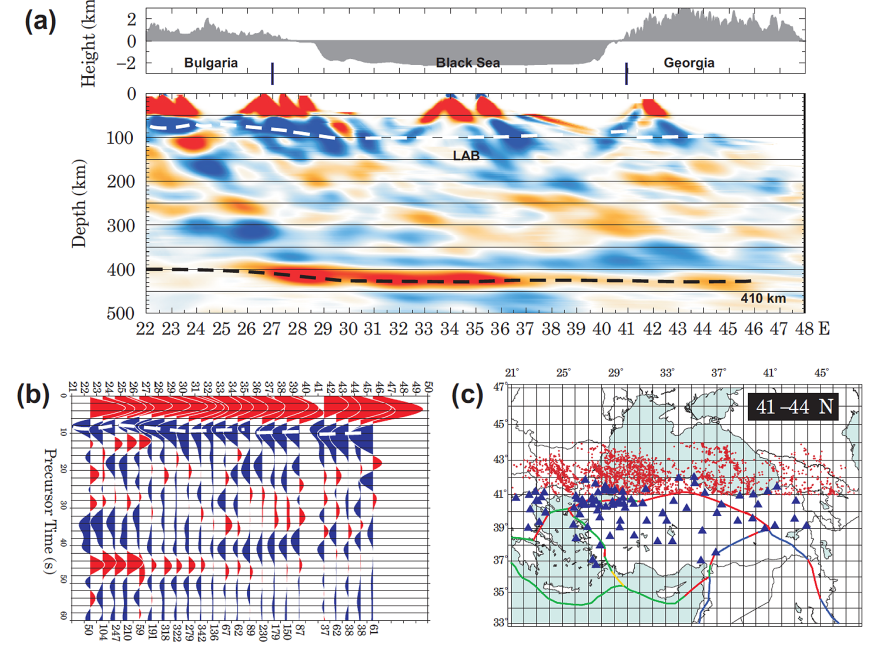
Figure 10. Same as Fig. 5 for an east–west profile between 41 and 44 ◦ N along northern Anatolia and the southern part of the Black Sea. The LAB appears very similar to the central Anatolian profile (Fig.